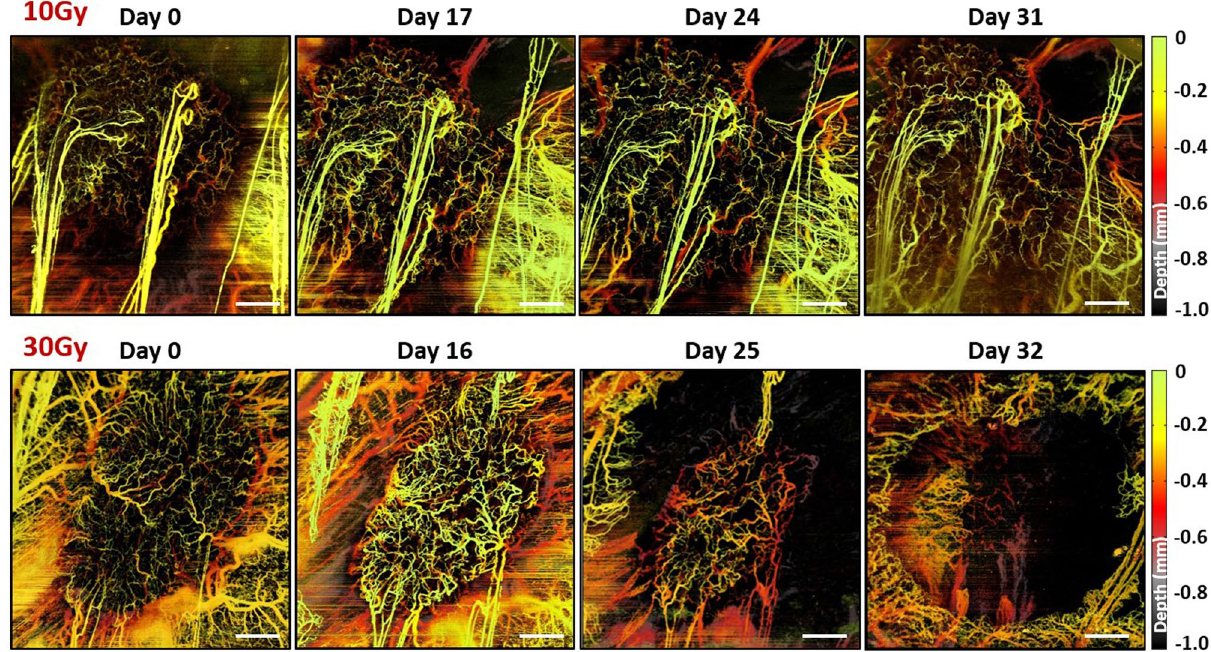
Figure 2. Tumour microvasculature images (before masking, depth-encoded here for better representation) used in analysis: (Top row) Days 0, 17, 24, and 31 time points of a tumour irradiated with 10 Gy; (Bottom row) Days 0, 16, 25, and 32 time points of a tumour irradiated with 30 Gy. Scale bars are 1 mm. Day 0 images for both cases are added for reference to initial tumour size, and to emphasize inter-tumour microvascular